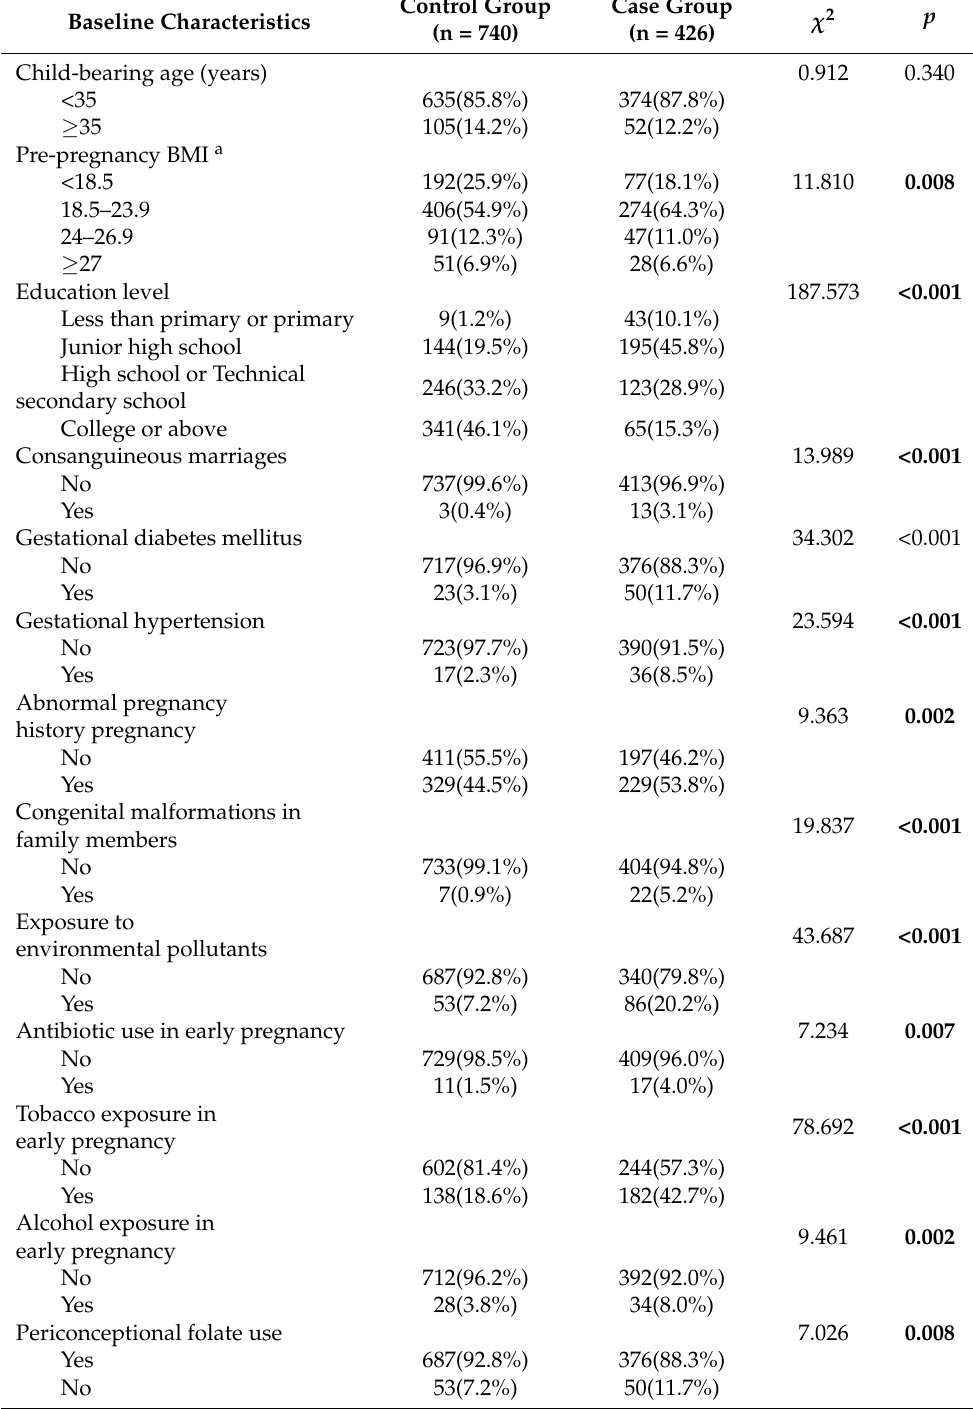
Table 1. Comparison of maternal baseline characteristics in cases and